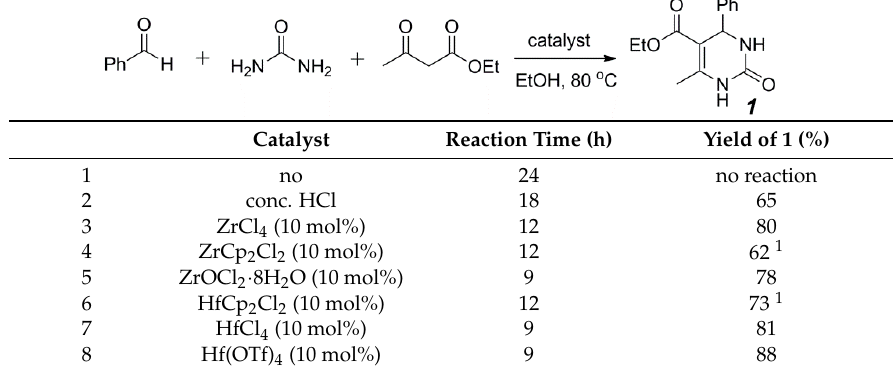
Table 1. Catalytic effect of Group IVB transition metal Lewis acids on Biginelli reaction.